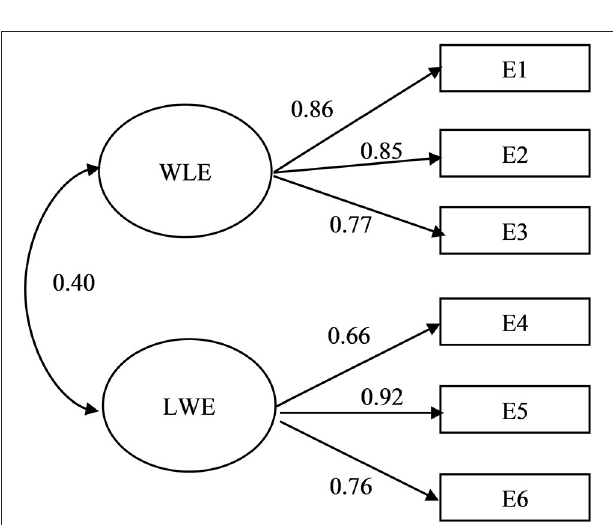
FIGURE 2 | Factor loading/correlations for a two-factor model of enrichment for women.